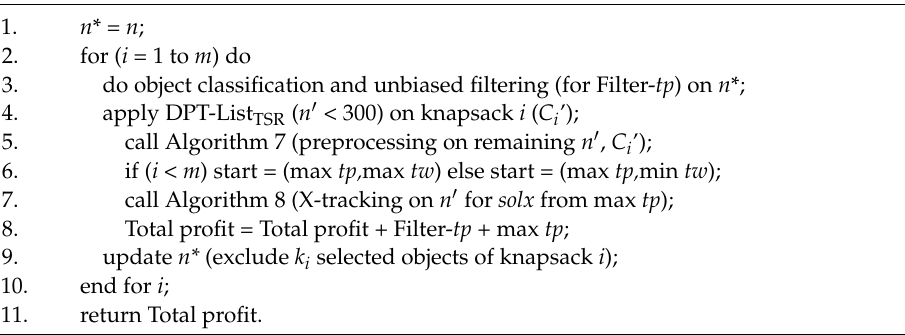
Figure 15. ( a ) The exact-fit policy plus efficient filtering for the best knapsack order and ( b ) an example of n = 33, m = 5, C = (66, 26, 80, 96, 70) to find the best order (2, 4, 1, 5, 3) in m ( m + 1)/2 = 15 steps and the optimal result (726) by the multi-DPT-List TSR + robust unbiased filtering. Algorithm 11: Multi-DPT-List TSR + robust unbiased